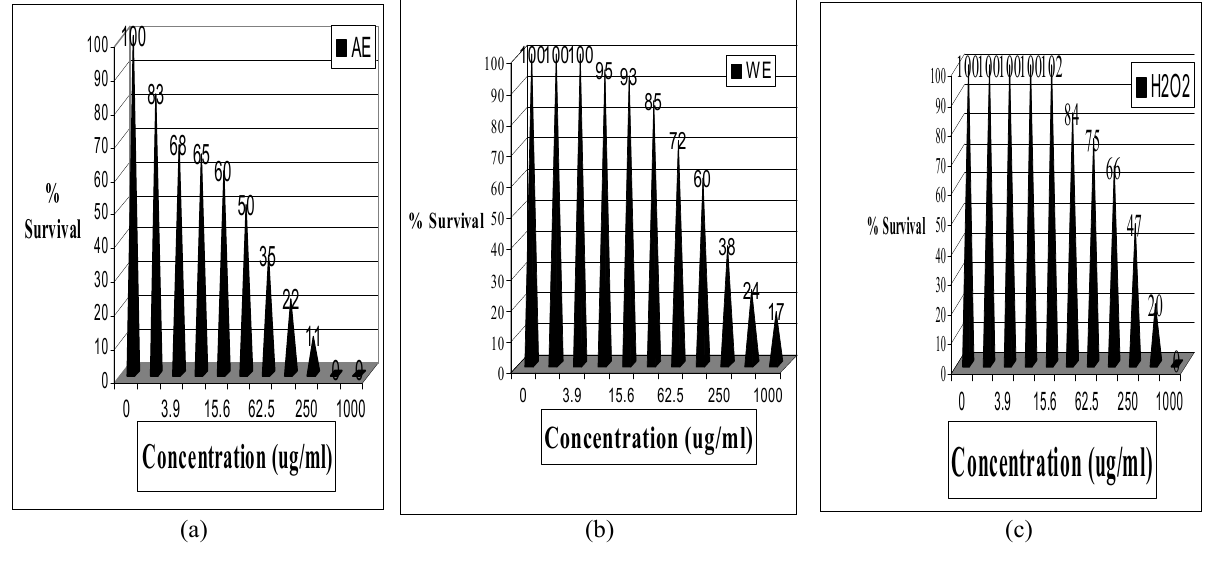
Figure 1 : Cellular response of MCF-7 breast cancer cell line to a 48 hour exposure to (a) alcohol extract of black seed (AE) (b) water extract of black seed and (WE) (c) hydrogen peroxide (H the FDA